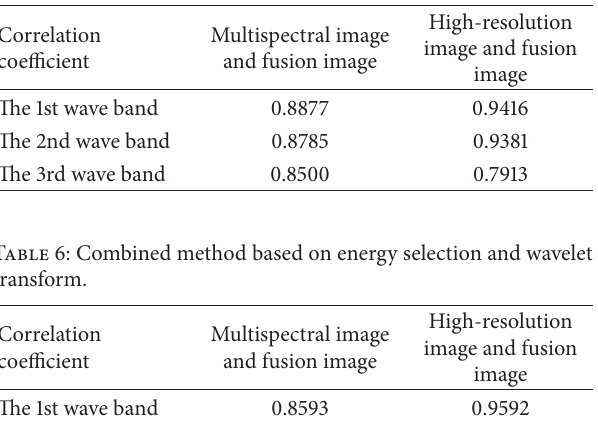
Table 5: Combined method of maximum and consistency detection of absolute value.